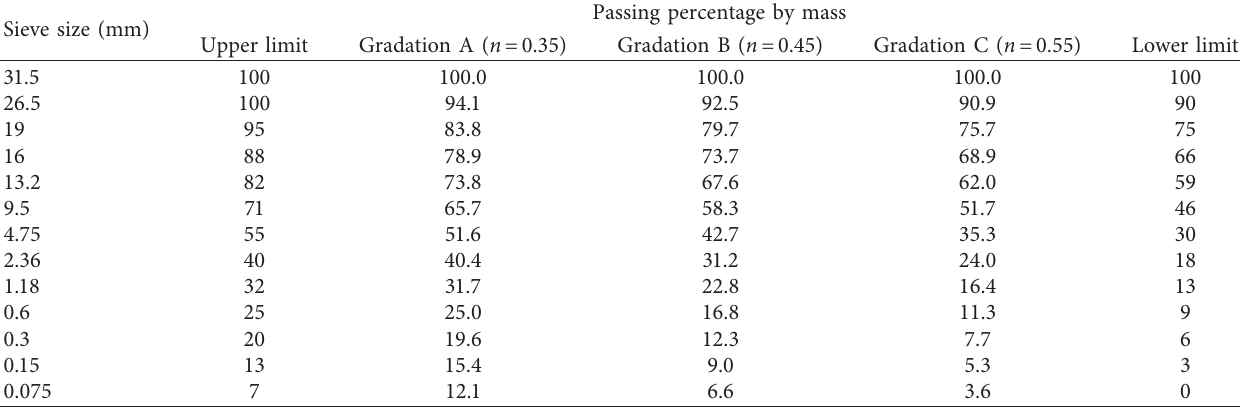
Table 4: Particle size distribution of granular base by maximum density curve.